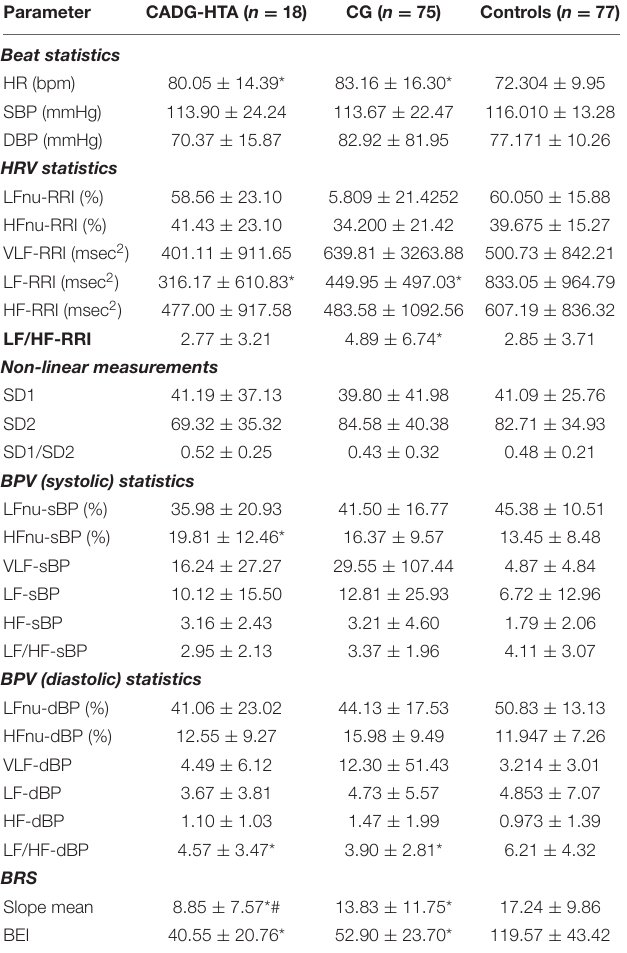
TABLE 9 | HRV and BPV in COVID-19 group with syncope (CADG-Syn).